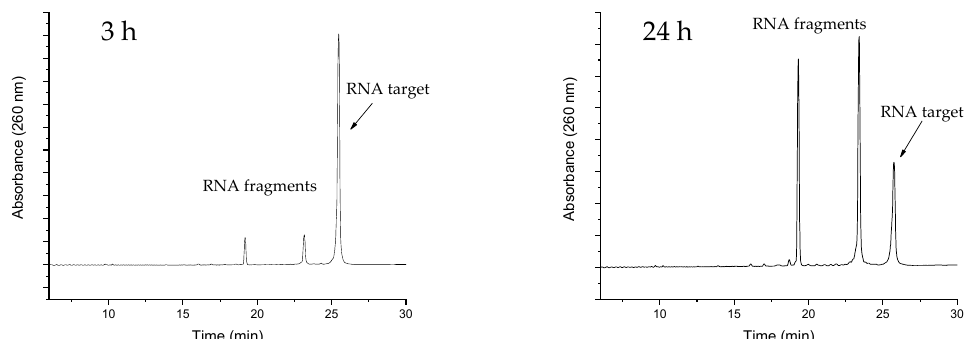
Figure 3. Representative IE HPLC chromatograms showing the extent of RNA cleavage after a 3- and 24-h reaction time in the presence of sub-stoichiometric PNAzyme II . The experiments were performed with a 10-fold excess of RNA 23 (4.0 µM) with respect to PNAzyme II (0.4 µM) in the presence of Cu 2+ (10 µM) at 37 °C, pH 7.0, in HEPES buffer (10 mM HEPES, 0.1 M NaCl).